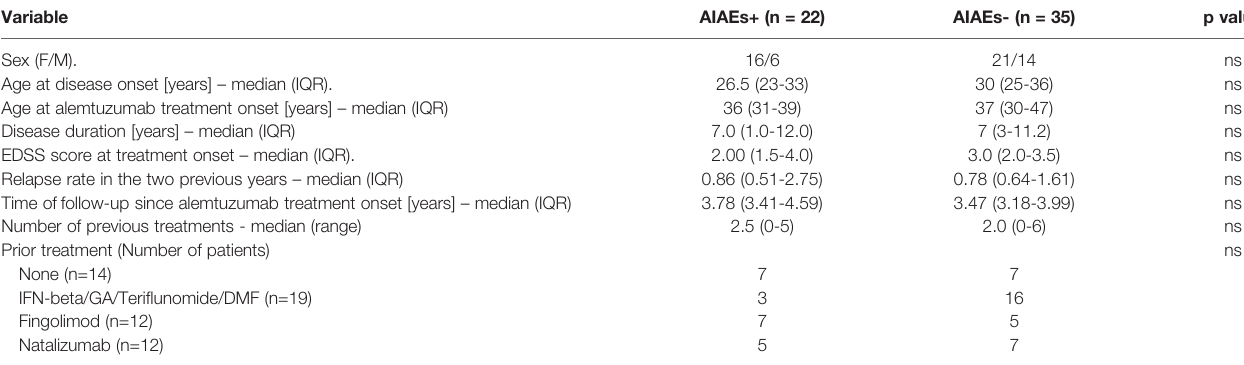
TABLE 2 | Clinical and demographic characteristics of patients classi fi ed according to the appearance of autoimmune adverse events. Variable Sex (F/M).